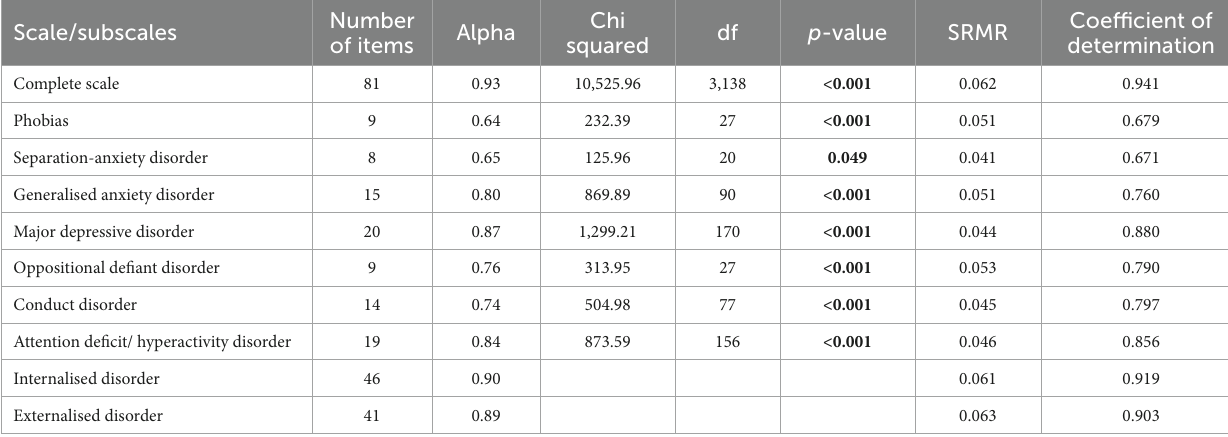
TABLE 6 Validity measures on the 1,479 Children